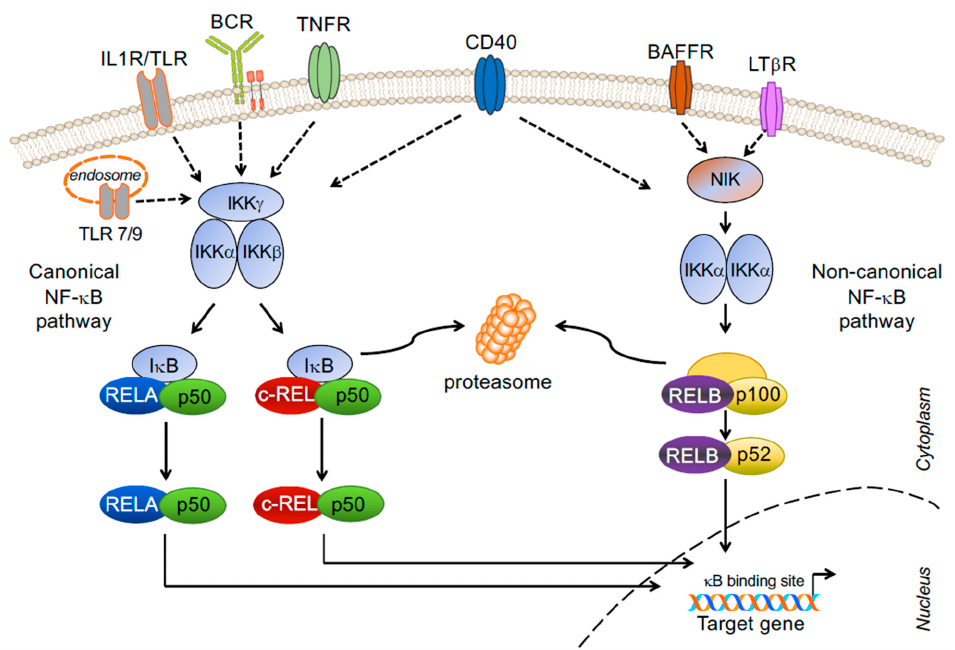
Figure 1. NF- κ B subunits and signaling pathways in B cells. Stimulation via cell surface receptors leads to activation of the IKK complex or NIK, the upstream regulators of the canonical and non- canonical NF- κ B pathway, respectively (adaptor molecules not shown). In the canonical pathway, phosphorylation of I κ B by IKKs causes its proteasomal degradation, thus releasing the NF- κ B di- mers RELA/p50 and c-REL/p50 for nuclear translocation. In the non-canonical pathway, NIK acti- vates IKK α , which in turn induces the processing of the p100 inhibitor κ B subunit to p52, thus re- leasing the NF- κ B dimer RELB/p52 for nuclear translocation. Only RELA, c-REL and RELB contain transactivation domains that drive transcription of NF- κ B target genes. RELA, c-REL and p50 are the subunits of the canonical (or classical) NF- κ B pathway that in B cells is activated by the BCR, Toll-like receptors (TLRs), and the members of the tumour necrosis factor receptor (TNFR) super family CD40, CD30 and Receptor Activator of Nuclear factor- κ B (RANK/TNFRSF11A) [38,39] [Figure 1]. These receptors utilize mul- tiple adaptor proteins to relay signals from the microenvironment to the major heterodi- mers of this pathway, RELA/p50 and c-REL/p50, which in resting cells are sequestered in the cytoplasm by the Inhibitory κ B proteins I κ B α , I κ B β and I κ B ε . Upon receptor activa- tion, phosphorylation of I κ B α by the I κ B kinase (IKK) complex, composed of two catalytic subunits (IKK α and IKK β ) and the regulatory subunit IKK γ (also known as NEMO), marks the I κ B protein for proteasome-mediated degradation, thus releasing the canonical NF- κ B heterodimers for nuclear translocation. Important negative regulators of the ca- nonical pathway are the deubiquitinating enzymes A20, encoded by TNFAIP3 , and CYLD, which act upstream of the IKK complex. activating factor (BAFF) (through the BAFF receptor), and/or lymphotoxin- β (LT β ) (via inactive through the rapid turn-over of NF- κ B-inducing kinase (NIK), which is trapped in a multiprotein inhibitory E3 ubiquitin ligase complex composed of TRAF2, TRAF3, and